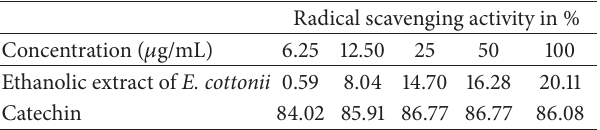
Table 1: Radical scavenging activity of ethanolic extract of E. cottonii